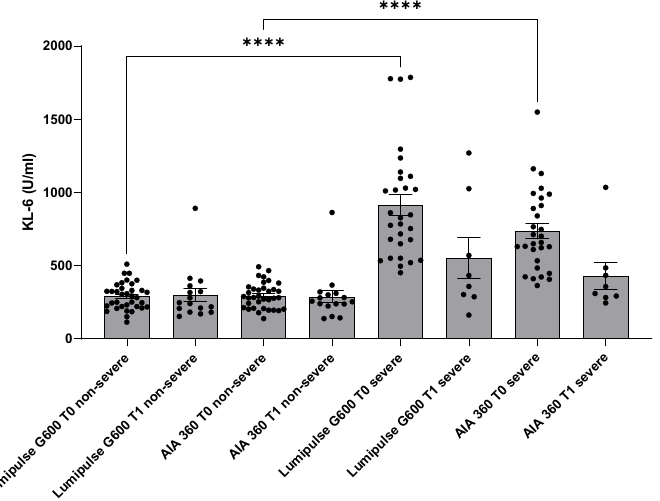
Figure 1. KL-6 concentrations detected by Lumipulse G600II and AIA360 at T0 and T1 stratifying COVID-19 patients according to disease severity. **** p < 0.0001.